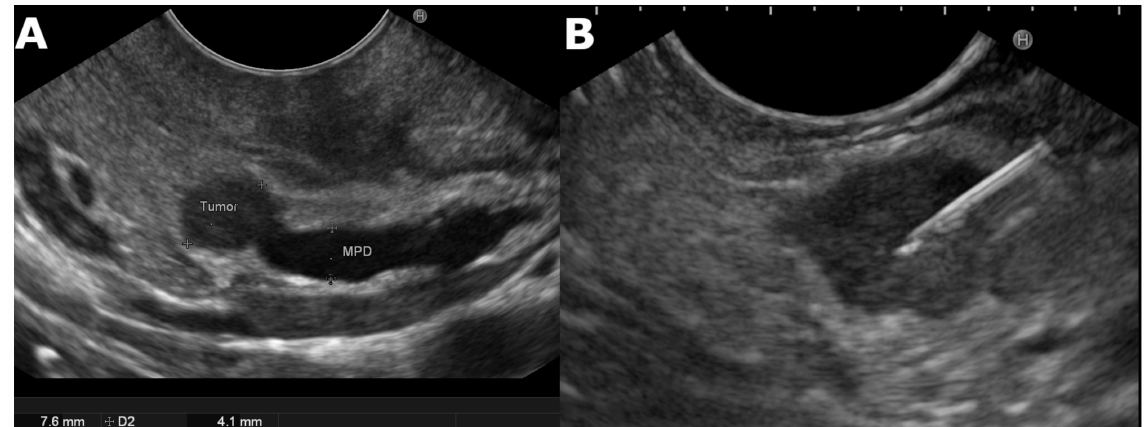
Figure 1. ( A ) Endoscopic ultrasound image of a small, well rounded, hypoechoic lesion with regular margin and dilated Wirsung in the head of the pancreas highly suggestive for neuroendocrine tumor. ( B ) The diagnosis of neuroendocrine tumor was confirmed by tissue specimen gathered using EUS-FNA. MPD, main pancreatic duct; D2,